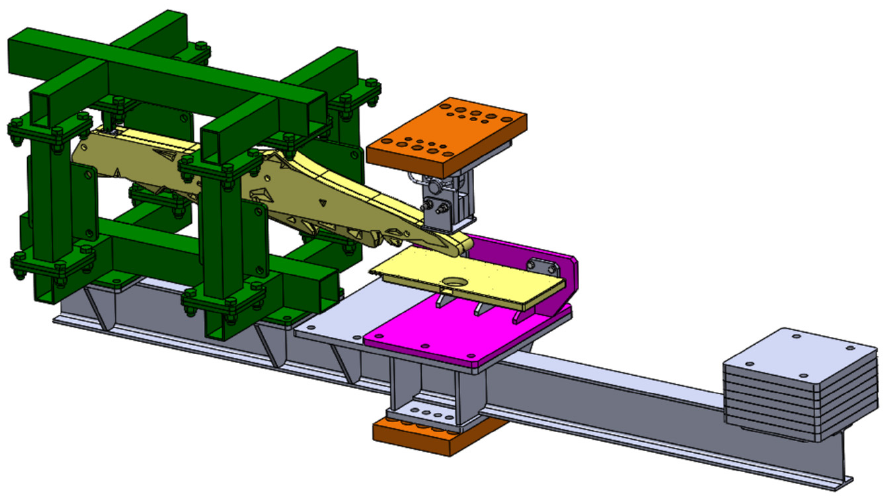
Figure 3. 3D model for the manufactured test stand.